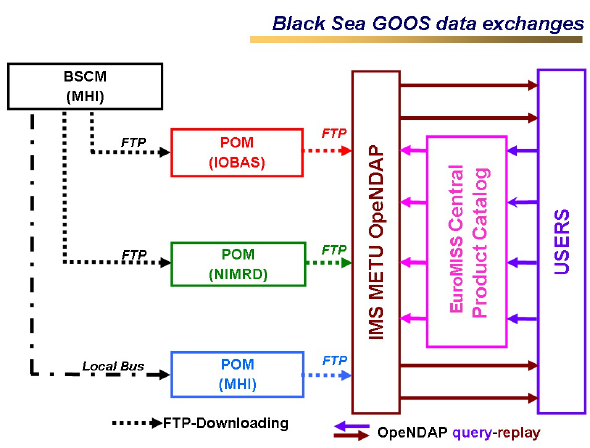
Fig. 4. The scheme of the data exchange in the Black Sea coastal nowcasting and forecasting